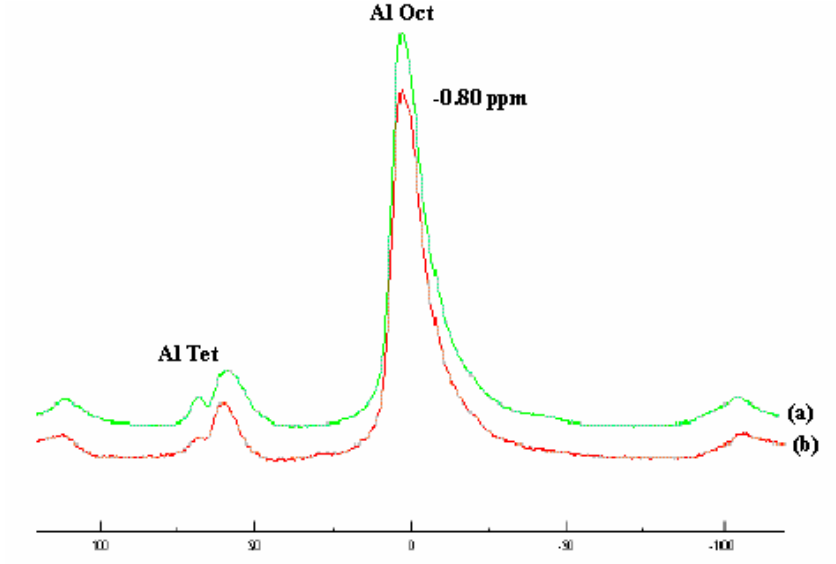
Figure 3. 27 Al MAS NMR spectra of (a) “Raw-Maghnite” and (b) “H-Maghnite0.25M”